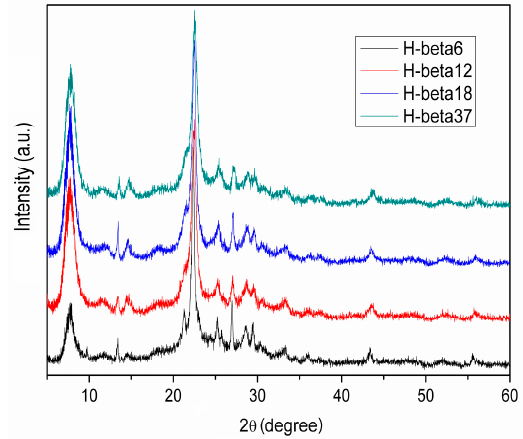
Figure 1. X-ray diffraction patterns of H- β samples.